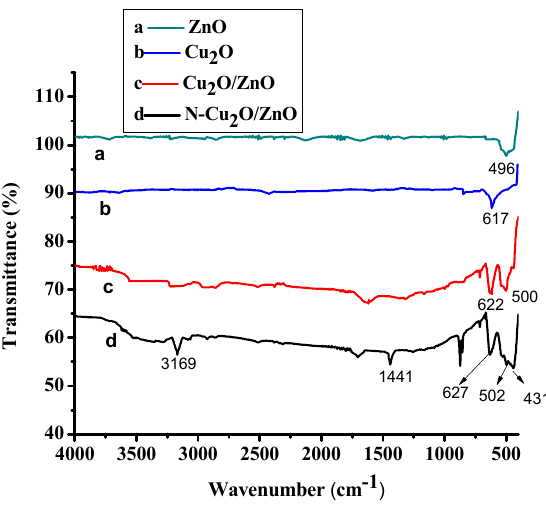
Figure 3. Fourier transform infrared (FT–IR) spectrums of (a) ZnO, (b) Cu 2 O, (c) Cu 2 O/ZnO and (d) N-Cu 2 O/ZnO nanomaterials.